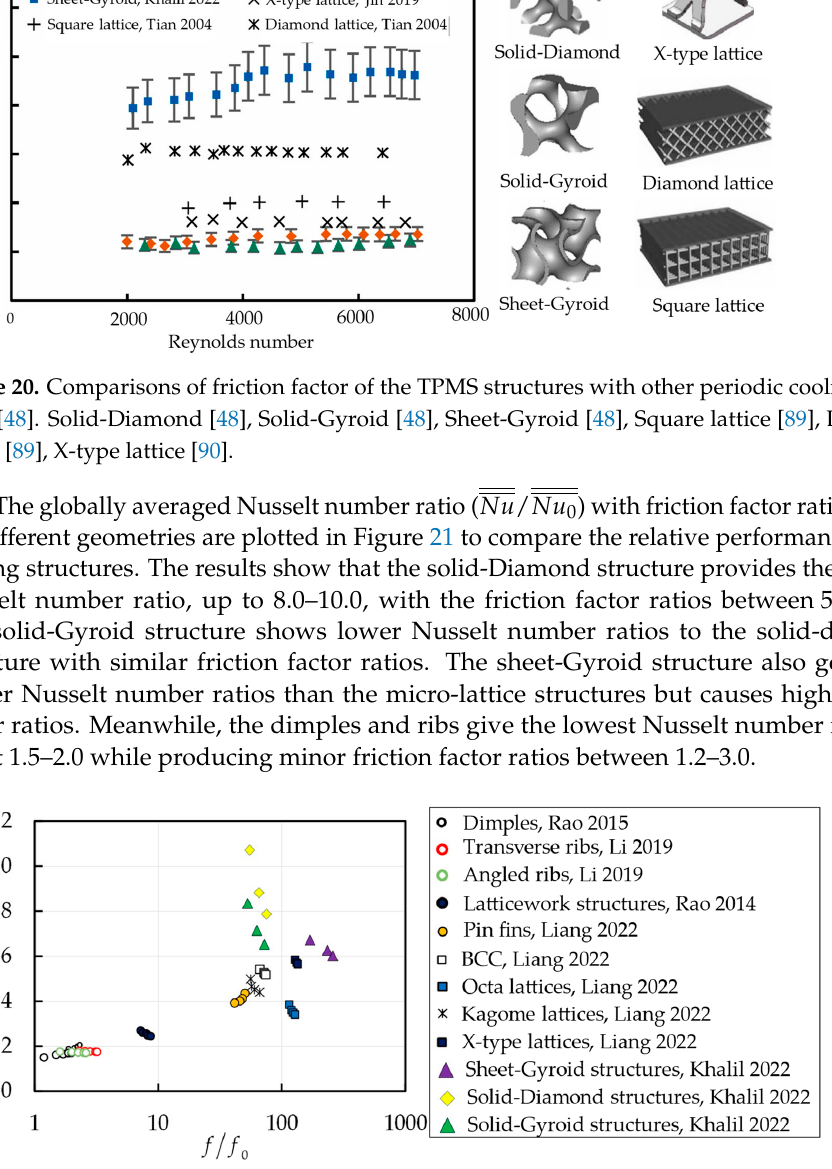
Figure 19. Comparisons of globally averaged Nusselt number of the TPMS structures with other cooling strategies. Dimples [86], Transverse ribs [87], Angled ribs [87], Latticework structures [88], Pin fins [13], BCC [13], Octa lattices [13], Kagome lattices [13], X-type lattices [13], Solid-Diamond structures [48,53], Sheet-Gyroid structures [48], Solid-Diamond structures [48], Solid-Gyroid structures [48].